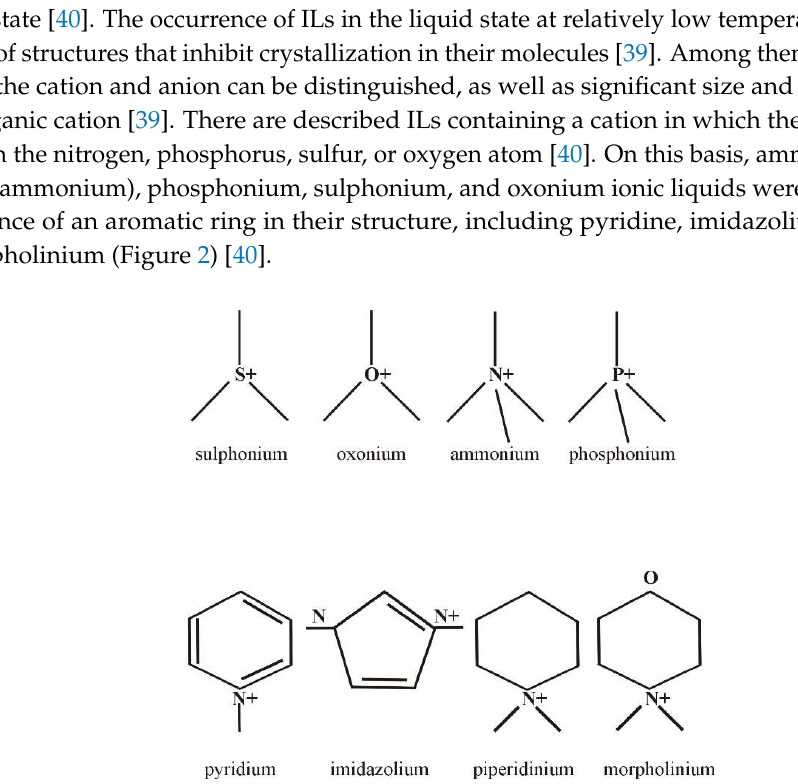
Figure2. Examples of cations in ionic liquids. Figure 2. Examples of cations in ionic